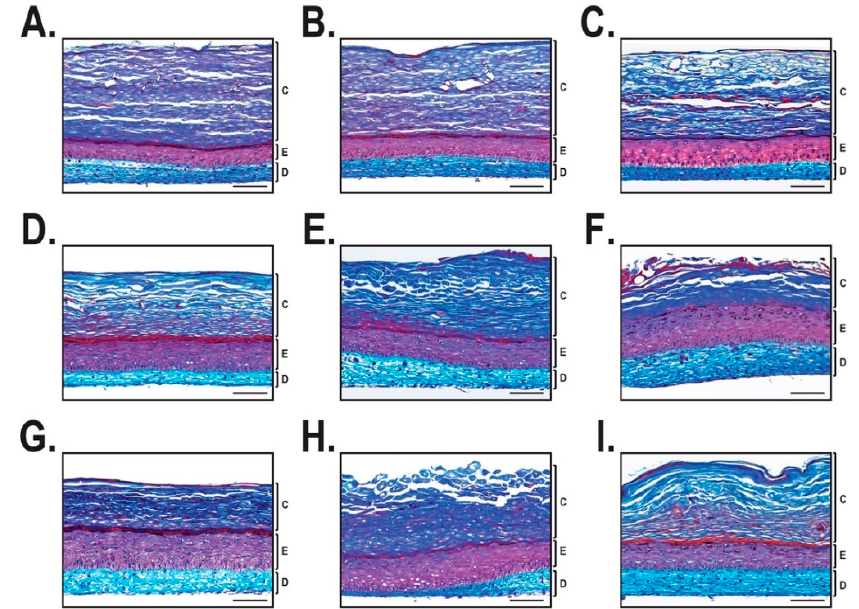
Figure 2. Histological analysis of the reconstructed skin substitutes. Mason’s trichrome staining after 21 days of culture at the air-liquid interface. For each group, tissue-engineered skin substitutes were produced with three different cell populations. ( A – C ) Healthy skin substitutes. ( D – F ) Non-lesional psoriatic skin substitutes. ( G – I ) Lesional psoriatic skin substitutes. Scale bar = 100 µm. C: Stratum corneum; E: Epidermis; D: Dermis.